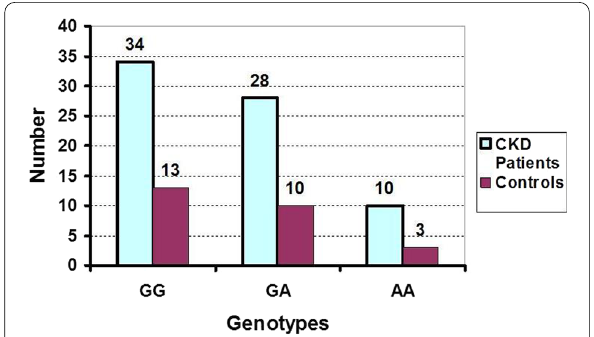
Fig. 2 Distribution of the 3 genotypes of FGF23 gene rs7955866 SNP in the two study